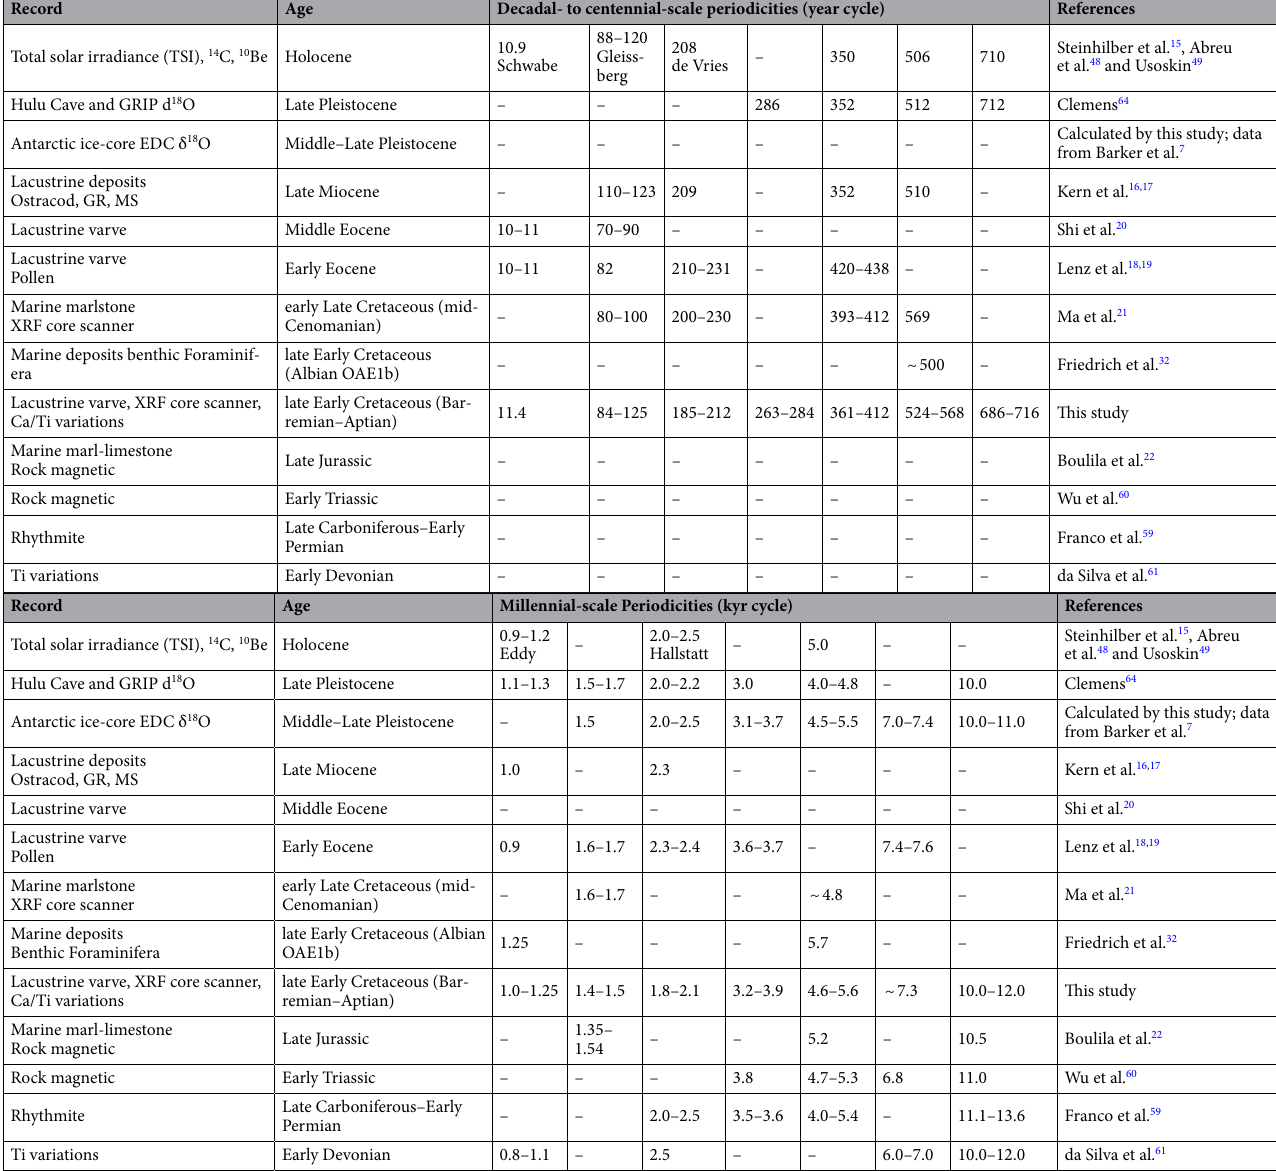
Table 1. Comparison of multiple frequency (decadal- to millennial-scale) periodicities identified in the geological